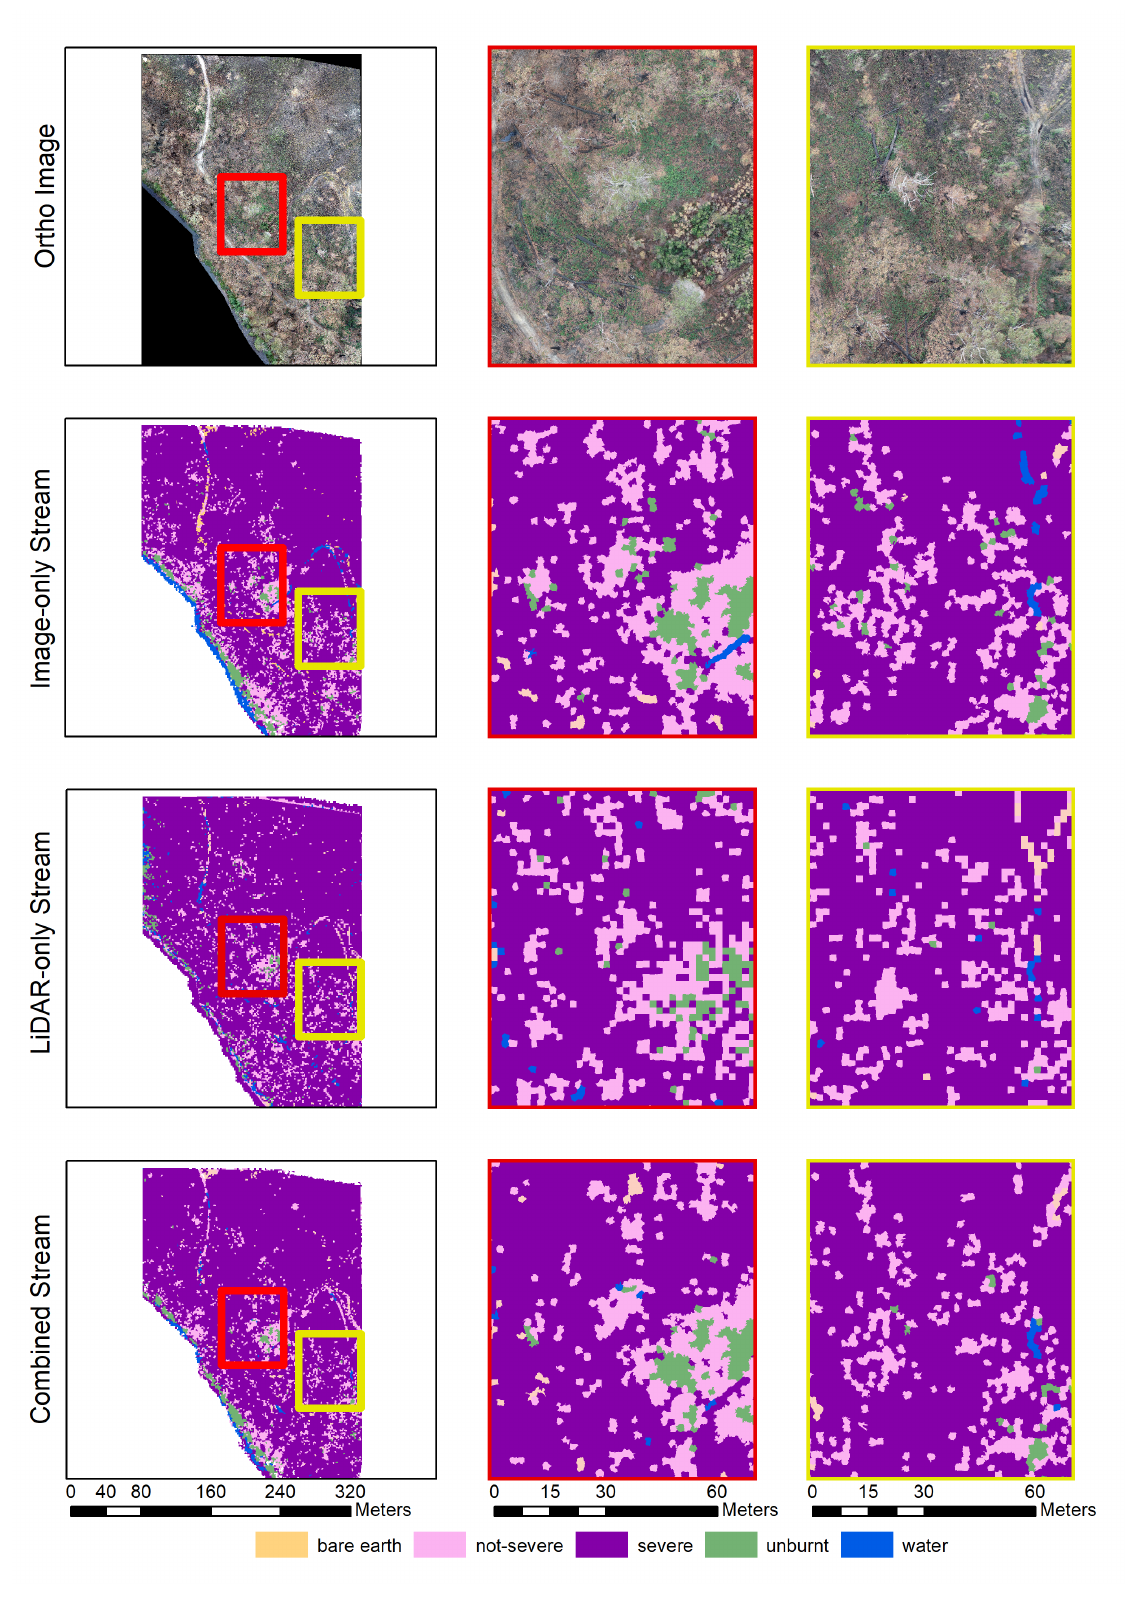
Figure 3. Fire severity maps produced from image-only, LiDAR-only and combined data